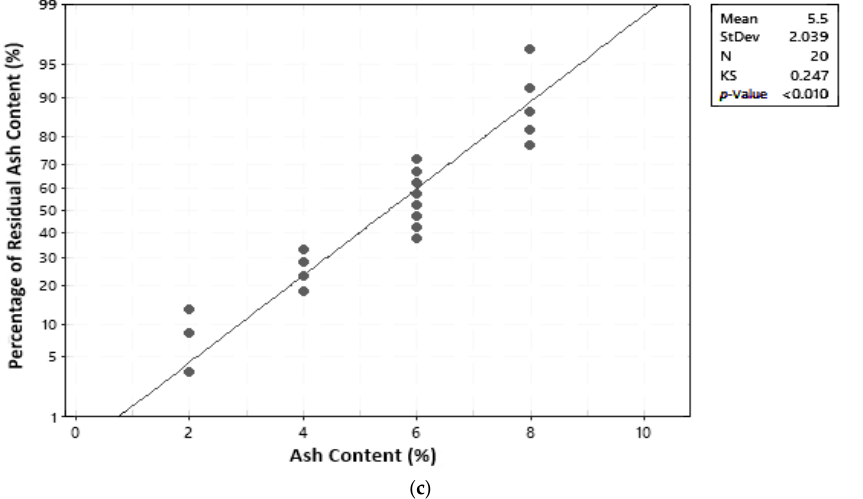
Figure 4. Normal distribution assumption test: ( a ) temperature; ( b ) water content; ( c ) ash content.